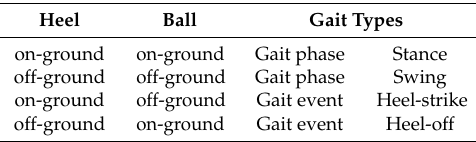
Table 1. Rules of gait phase detection